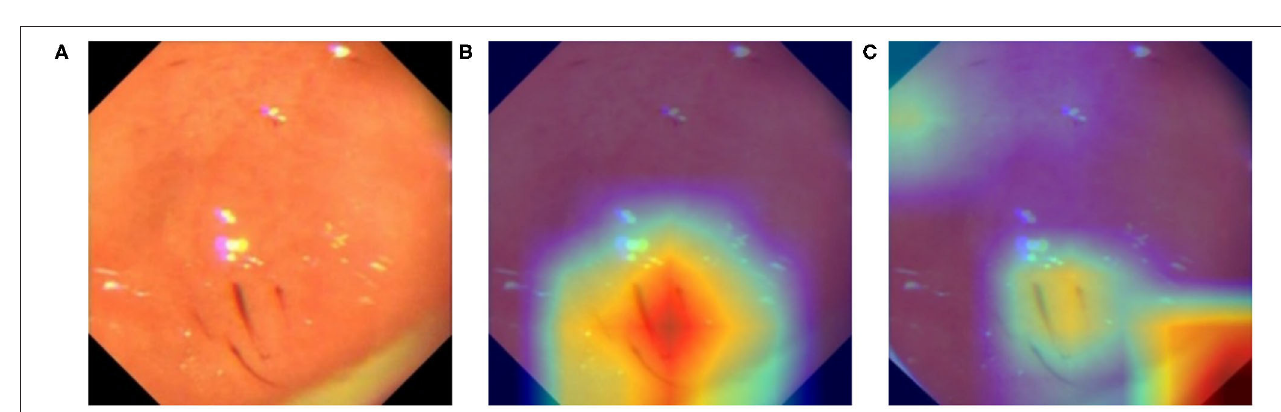
FIGURE 9 | Activation map of an erosive image with GradCam. (A) Original image. (B) Heatmap (GradCam) on the corrected lesion location. (C) Flawed heatmap focused on irrelevant image corners.